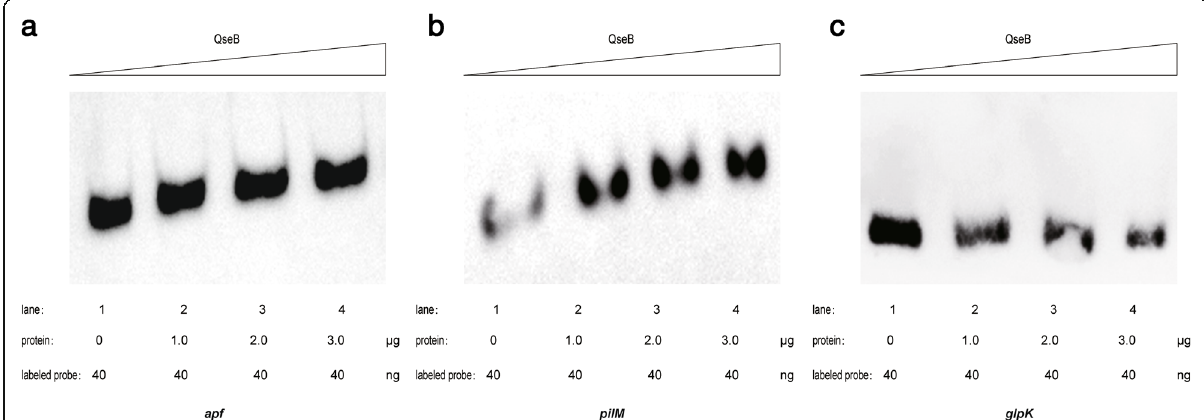
Fig. 3 Electrophoretic mobility shift assay of interaction between QseB and the promoter regions. Different amount of purified QseB protein was incubated with DNA fragment of promoter region of apf ( a ), pilM (positive control) ( b ) and glpK (negative control) ( c